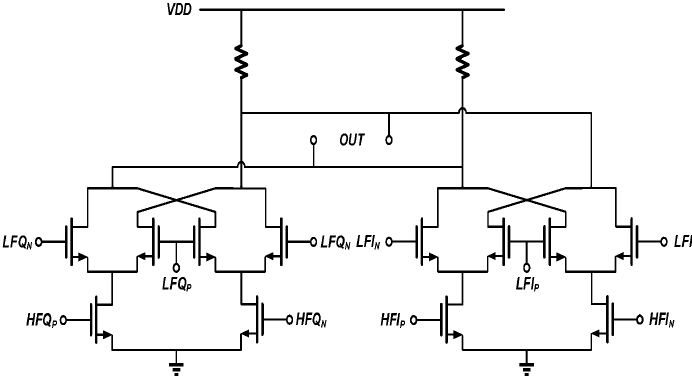
Figure 10. Quadrature mixer to generate V L F . The inputs signal LF and HF are both quadrature differential, and the output is differential.